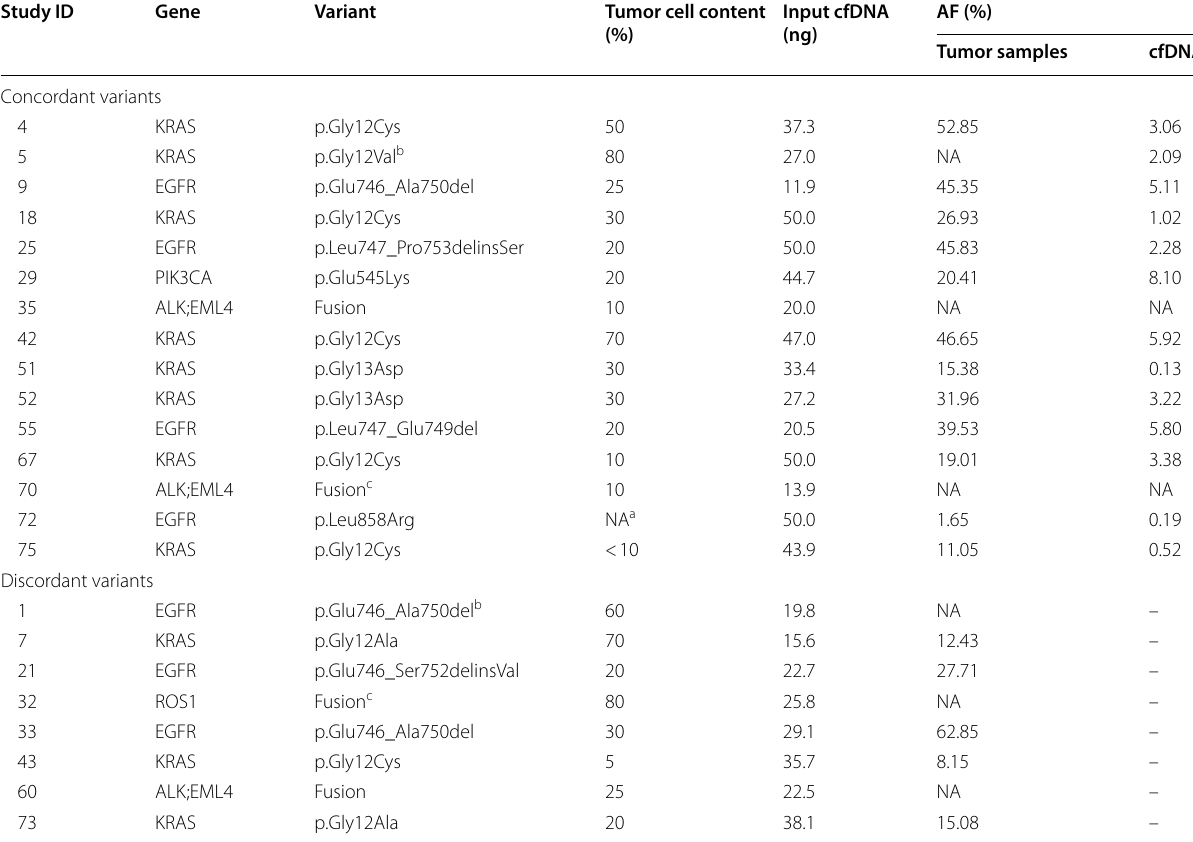
All variants detected in clinically relevant genes in tumor samples are included and each line represents one case AF allele frequency a Cytological